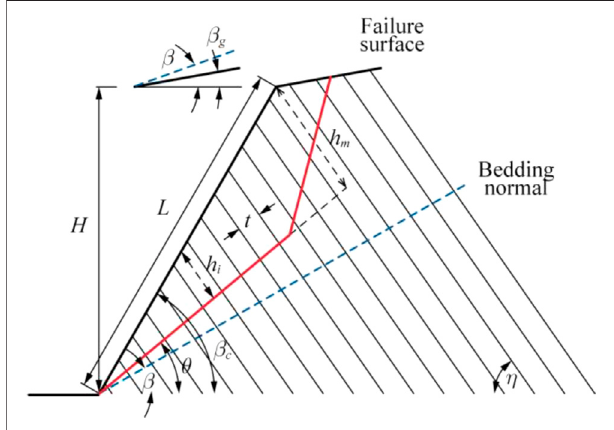
FIGURE 1 | Geological model of fl exural toppling failure (modi fi ed from Chen et al. (2016).